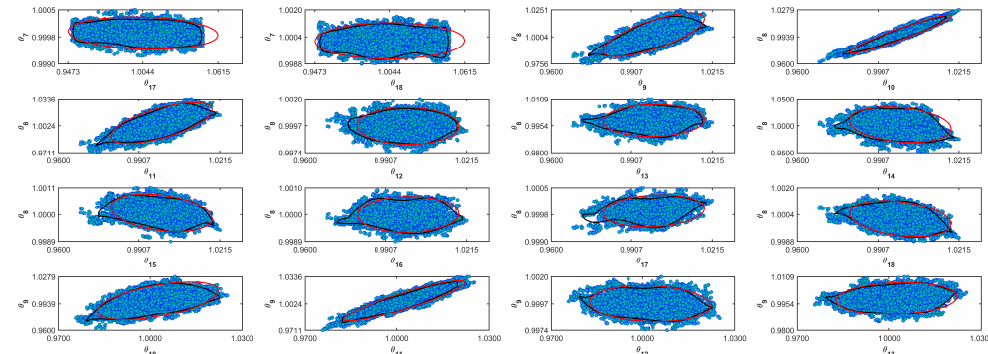
Figure A7. Coverage regions of parameters 07: (—) Gaussian region; (—) Possolo [33] region.